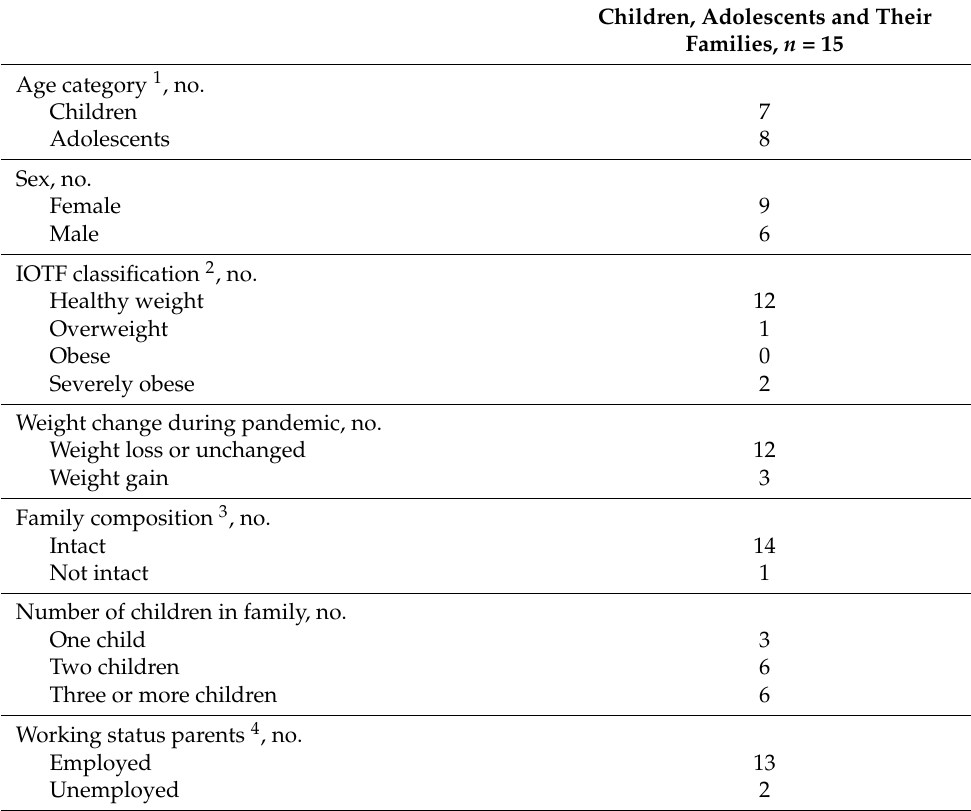
Table 1. Characteristics of the included children, adolescents and their families.